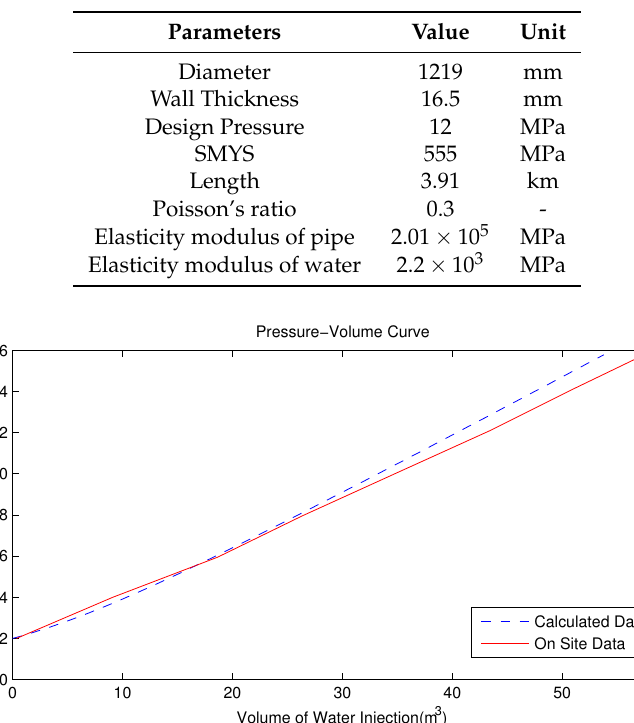
Figure 1. Planar drawing of the tested pipeline. Table 1. The parameters of the test pipeline section.